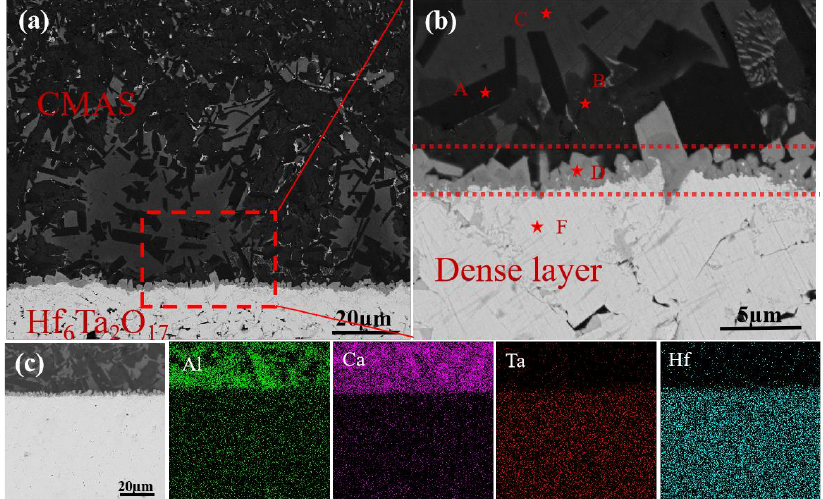
Figure 6. ( a , b ) Cross-sectional BSE images of Hf 6 Ta 2 O 17 ceramic after CMAS corrosion at 1250 °C for